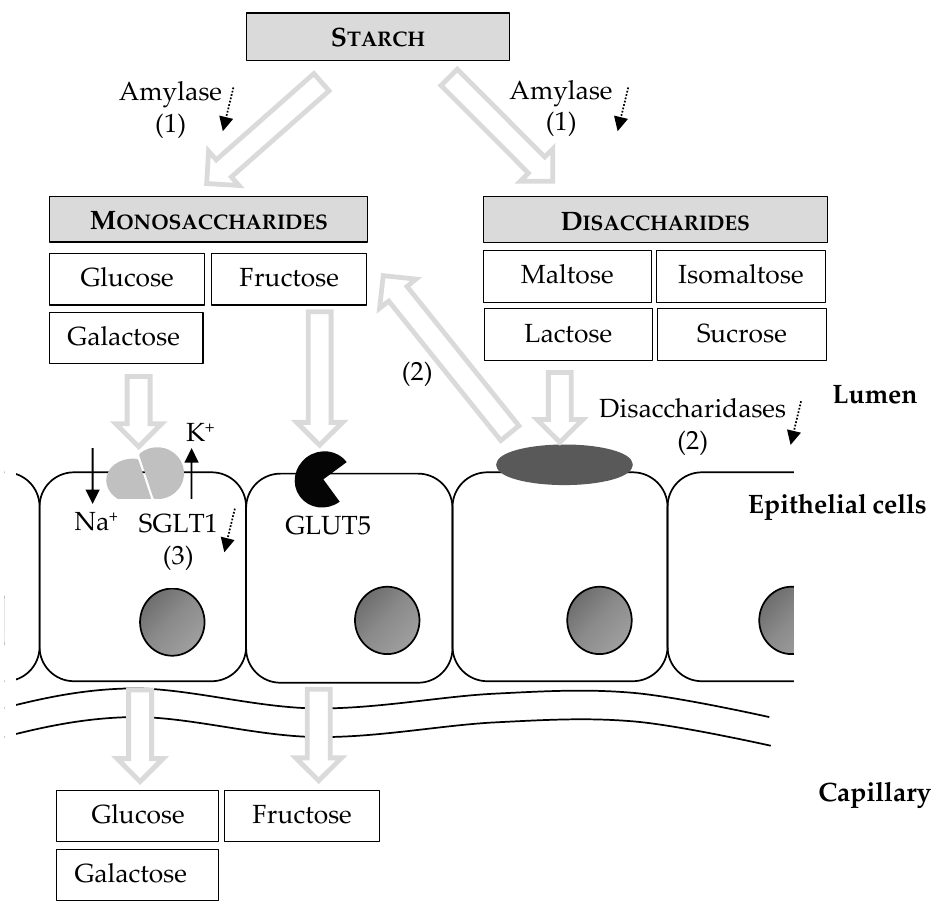
Figure 2. Starch digestion and absorption of monosaccharides in cats: (1) Cats have very limited salivary amylase and intestinal amylase activity is low; (2) adult cats have low disaccharidase activity in the small intestinal brush border; (3) the Na+/glucose co-transporter 1 (SGLT1) for active transport of glucose and galactose is expressed in cats, but the Na+-dependent glucose uptake is two times slower than in dogs and inability to upregulate SGLT1 has been suggested in cats.